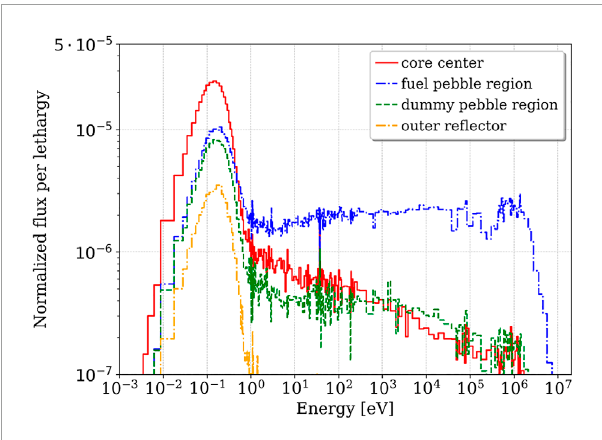
FIGURE 6 Normalized neutron flux of the UCB PB-FHR at the core axial midline, at different radial positions.